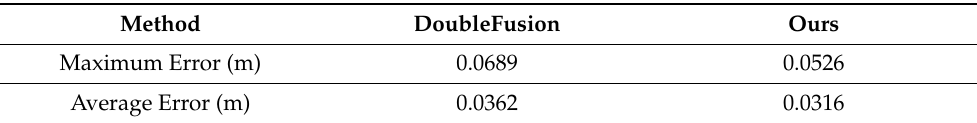
Table 2. Average numerical errors on the entire